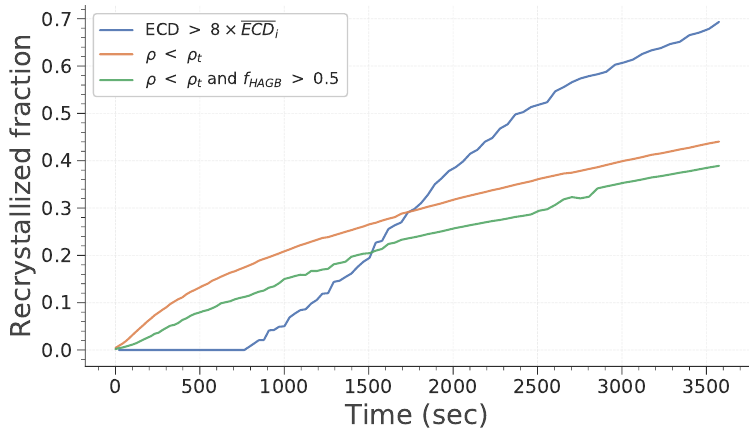
Figure 10. Evolution of recrystallized fractions with